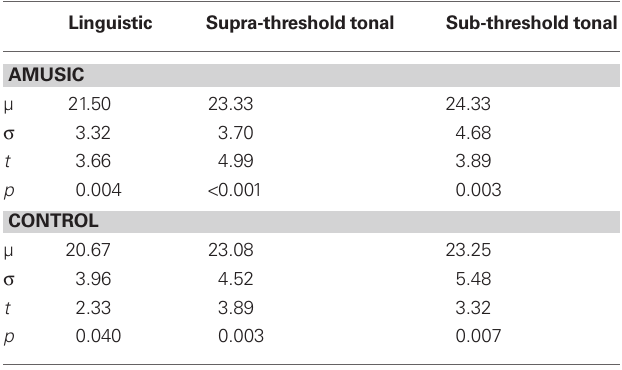
Table 4 | Results of Pearson correlations (df = 10) between the overall performance of both groups in the two conditions and psychophysically measured pitch direction and discrimination